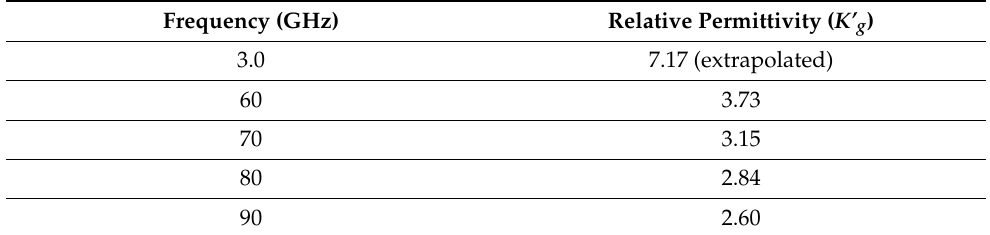
Table A3. Relative permittivity K’ g of zeolite Y in air at different frequencies.